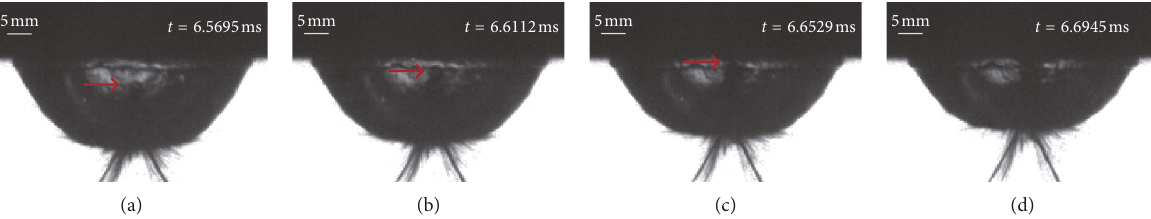
Figure 9: The procedure of the induced water jet impacting on the target plate with 20mm standoff. (a) t � 6.5695ms. (b) t � 6.6112ms. (c) t � 6.6529ms. (d) t � 6.6945ms.